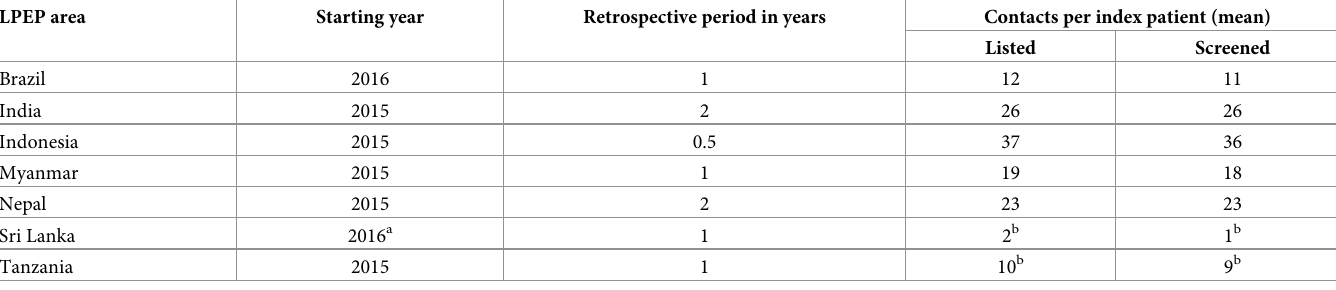
Table 1. Area-specific LPEP program characteristics as quantified in the model. LPEP